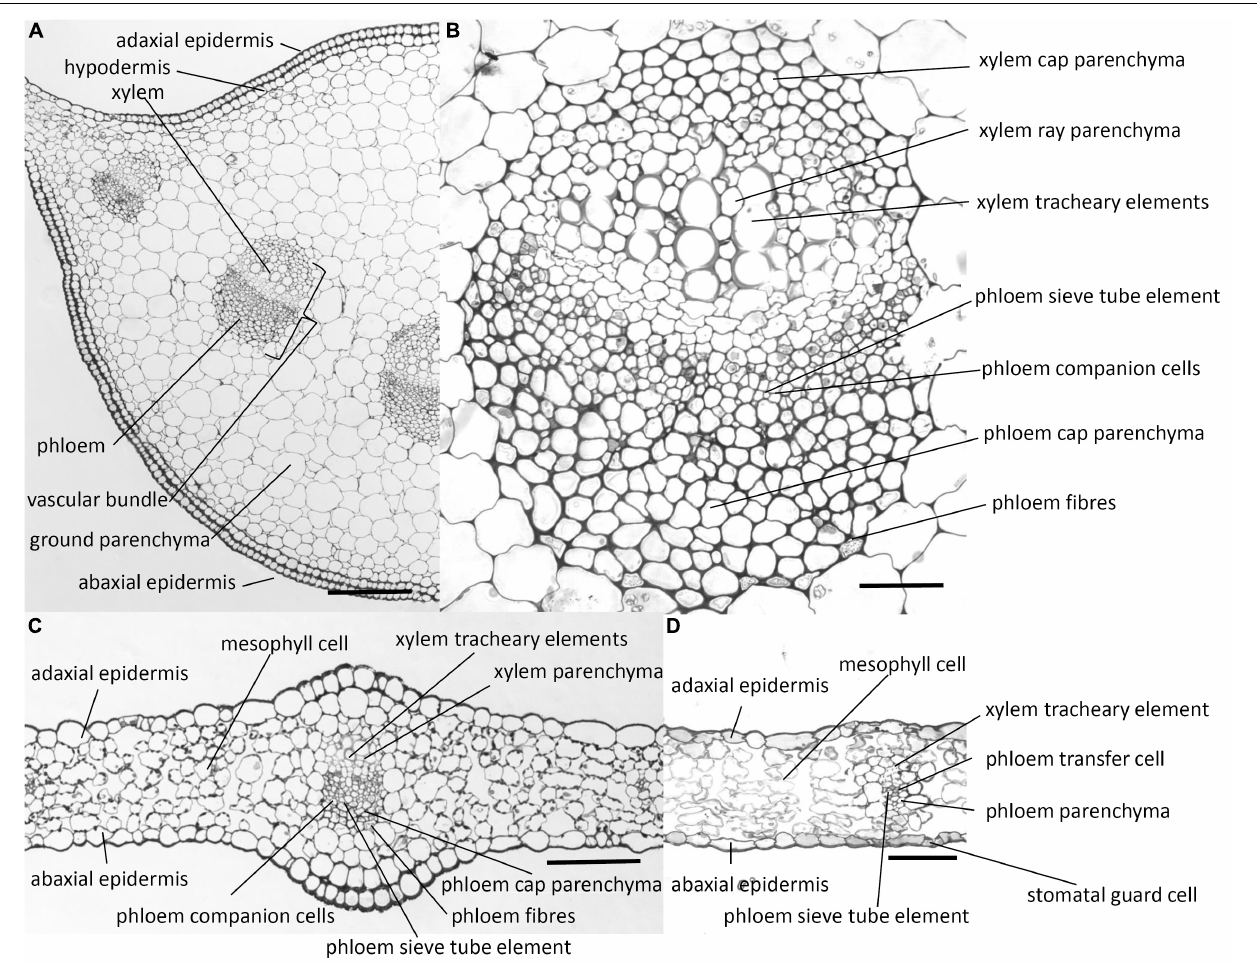
FIGURE 1 | Photomicrographs of transverse sections cut from a rosette leaf of an 8-week-old chicory plant. (A) A transverse section of the midrib. (B) A vascular bundle in the midrib. (C) A transverse section of the lamina with a major vein. (D) A transverse section of the lamina with a minor vein. Although it is difficult to identify the transfer cells, sieve tube elements, and companion cells in the photomicrographs, the lines point to where these cell types occur. Bars: (A) 200 µ m; (B) 40 µ m; and (C,D) 100 µ